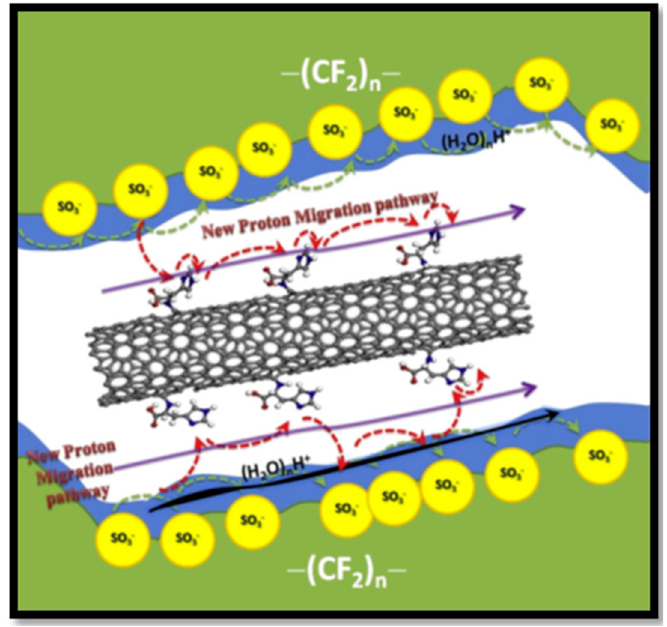
Figure 7. Proton conduction mechanism in Nafion ® -ImCNTs composite membrane. Reproduced from [29] with permission from Elsevier, 2013.